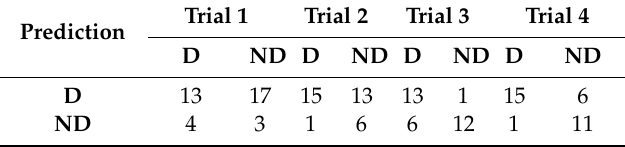
D, diabetes; ND, no